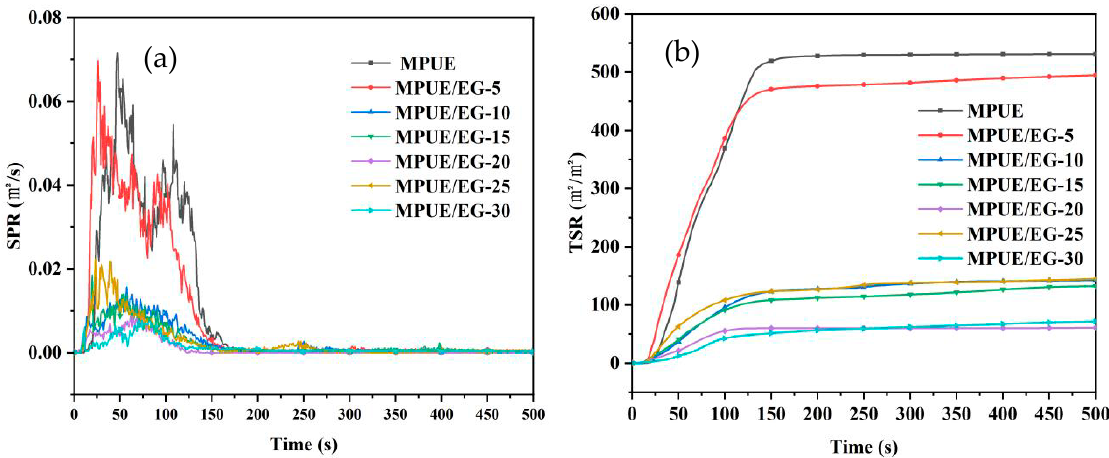
Figure 12. ( a ) SPR and ( b ) TSR curves of MPUE/EG.